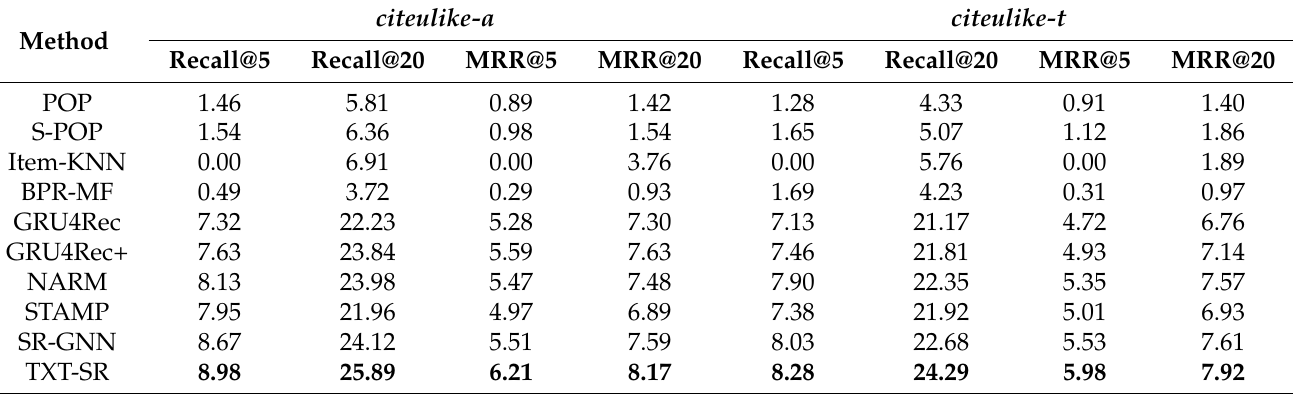
Table 3. Comparison with the current mainstream